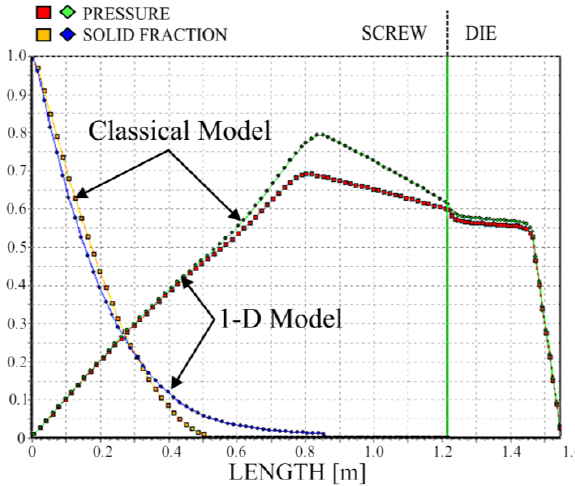
Figure 11. Solid bed profile and pressure profile for 1-D and 2-D simulations, N = 20 rpm.